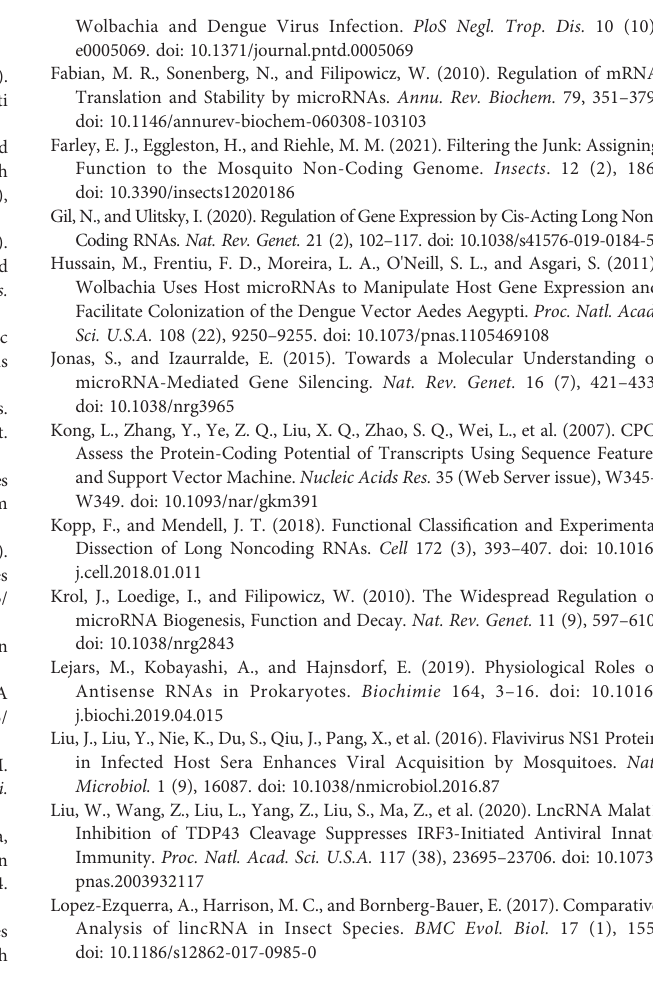
Supplementary Figure 1 | Schematic representation of the construct psi- CHECK-2 plasmids used in dual luciferase reporter assay. (A) psi-CHECK-2-WT- 0165 contains a 26-nt aae-lnc-0165 sequence that includes the predicted binding sites with aae-miR-980-5p marked in red. (B) psi-CHECK-2-MUT-0165 contains a 26-nt aae-lnc-0165 sequence that includes the mutated binding sites with aae- miR-980-5p. (C) psi-CHECK-2-WT-REL1 contains a 27-nt sequence from the coding region of REL1 gene which includes the predicted binding sites with aae- miR-980-5p. (D) psi-CHECK-2-MUT-REL1 contains a 27-nt sequence from the coding region of REL1 gene which include the mutated binding sites with aae-miR- 980-5p. Supplementary Figure 2 | Fold change of aae-miR-980-5p at 120-hour post transfection; ** P < 0.01, * P <